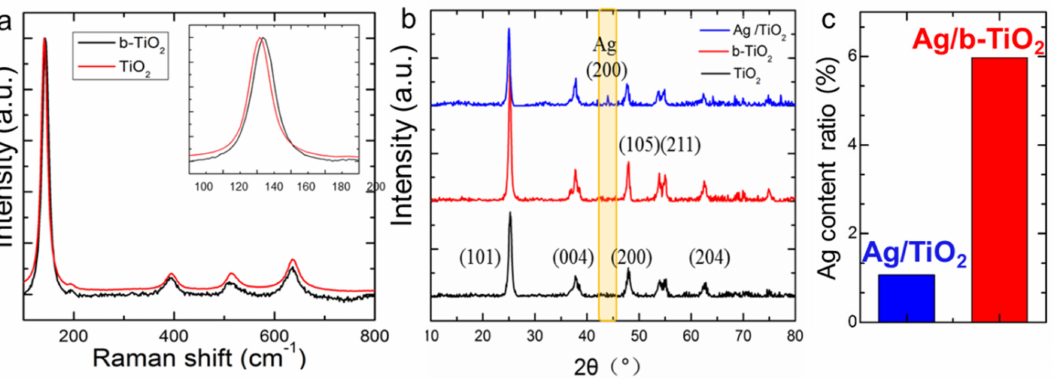
Figure 3. Structural characterizations of TiO 2 , b-TiO 2 , and, Ag/b-TiO 2 samples. ( a ) Raman spectra of TiO 2 and b-TiO 2 . ( b ) XRD patterns of TiO 2 , b-TiO 2 , and, Ag/b-TiO 2 samples. ( c ) The comparison of Ag content between Ag/TiO 2 and Ag/b-TiO 2